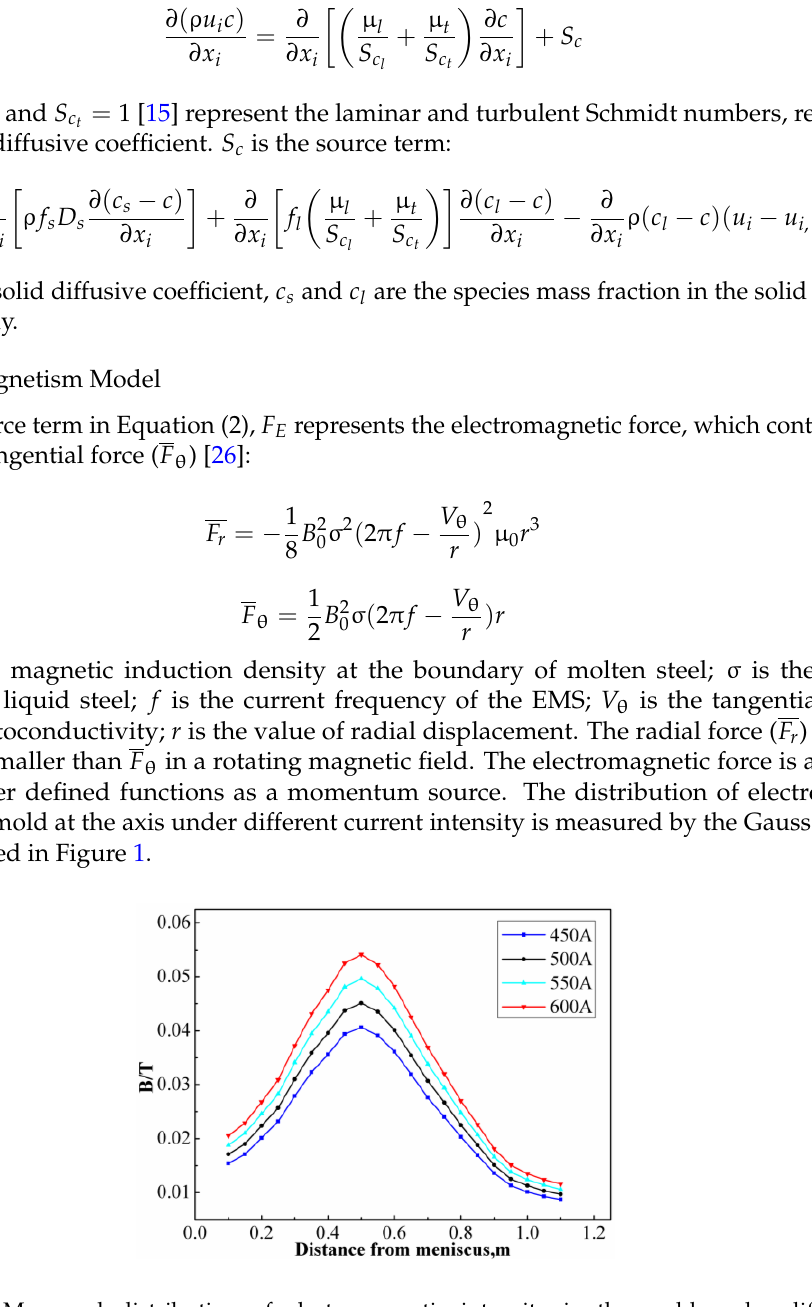
≤0.15 Figure 2. The three-dimensional view ( a ) and installation method ( b ) of submerged entry nozzle (SEN).